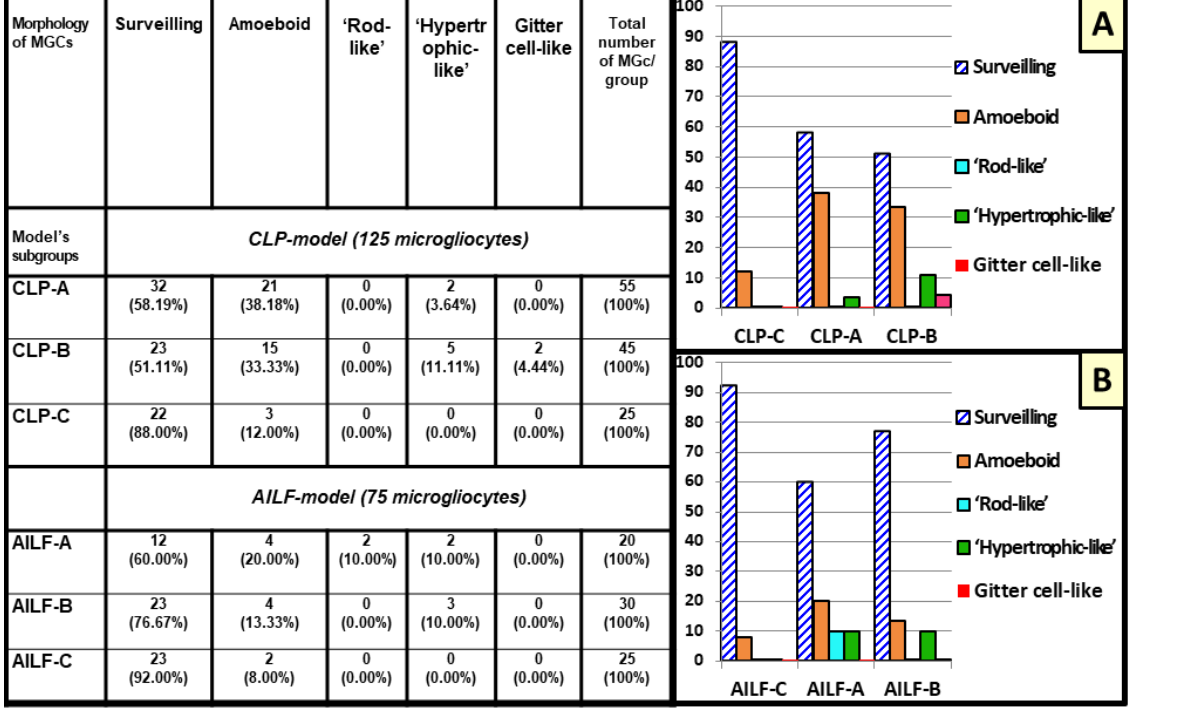
Figure 4. The distribution of microglia (MGc) morphotypes in the subgroups of cecal ligation and puncture (CLP) and acetaminophen-induced liver failure (AILF) models (expressed in the numbers of MGC morphotype (units) and the percentage from the total number of analyzed MGCs (%) per group) with color-coded bar graphs A and B. Panel ( A ) depicts CLP models: CLP-A (survived animals); CLP-B (non-survived animals); CLP-C (control). Panel ( B ) depicts AILF models: AILF-A (survived animals); AILF-B (non-survived animals); AILF-C (control animals).